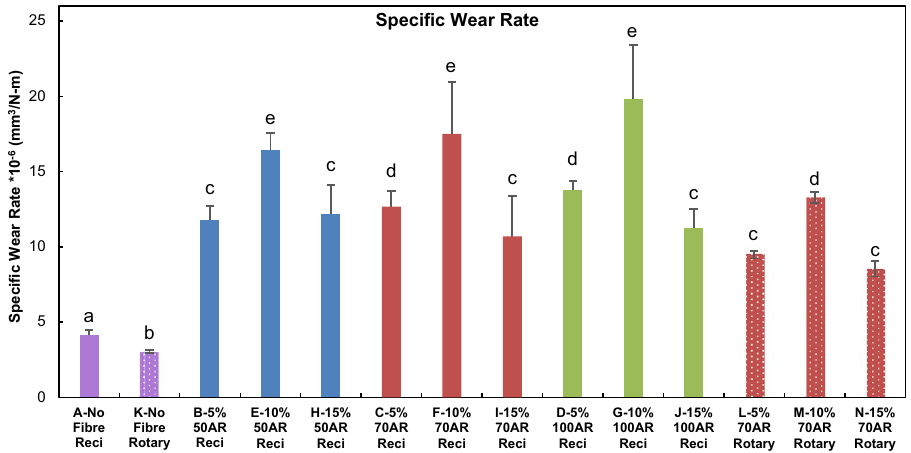
Figure 3. The specific wear rate of tested Groups along with the corresponding standard deviation. Groups with the same alphabets are not significantly different from each other (p > 0.05).